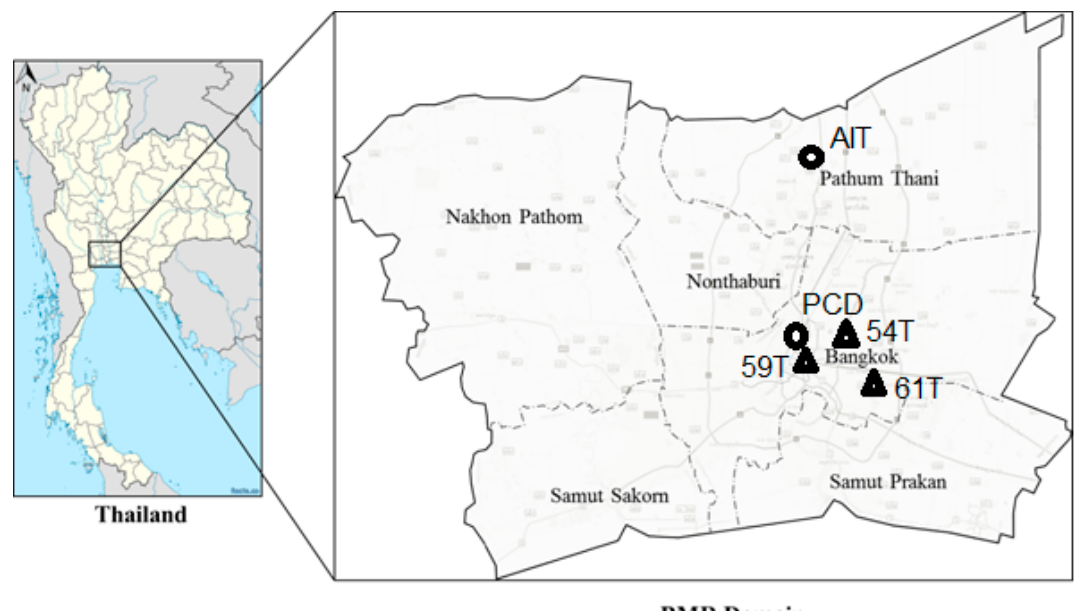
Figure A1. Map of the locations of PM 2.5 monitoring stations in Bangkok Metropolitan Region having the monthly levels presented in Figure 1. Note: AIT: JICA sites: Asian Institute of Technology (AIT), and Pollution Control Department (PCD). PCD automatic monitoring stations: 54T (Din Daeng), 59T (Government public relation department), and 61T (Bodindecha).